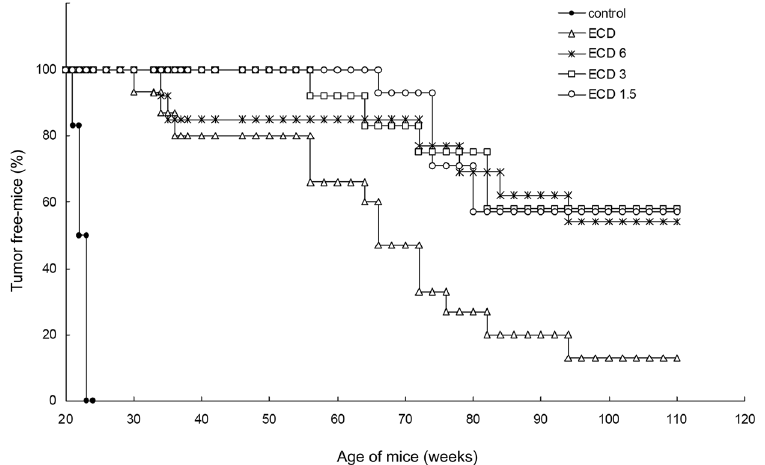
Figure 1. Effect of BI on tumour incidence. After SI, three groups of mice (15 mice/group) received BI every 6 (ECD6), 3 (ECD3), or 1.5 (ECD1.5) months. A control group received pCMV. Data shown are representative of one of two independent experiments. Difference in tumour incidence, as assessed by the Mantel–Haenszel log-rank test, was significant between ECD versus Control (p < 0.001) and ECD1.5, ECD3, and ECD6 versus control or ECD (p <